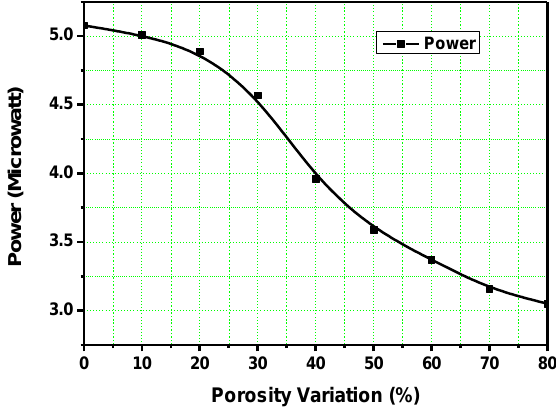
Figure 8. Porosity effect on output power.